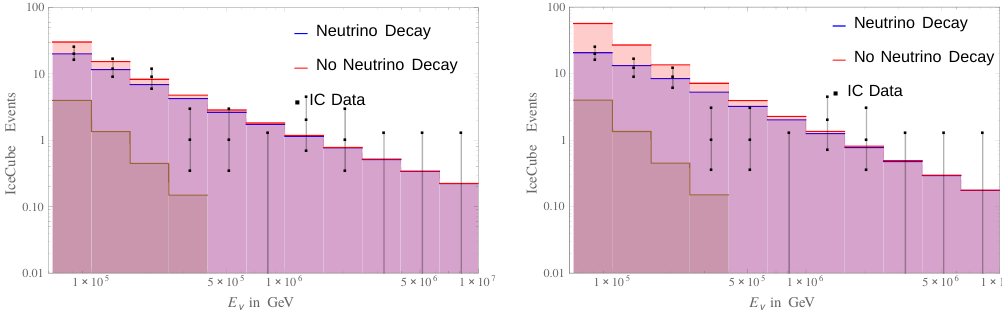
Figure 6 . IceCube event distribution with comparison of the cases of no neutrino decay for a. (cid:8) 0 = 2 (cid:2) 10 (cid:0) 18 (GeV cm 2 s sr) (cid:0) 1 , (cid:13) = 2 : 8 (left) b. (cid:8) 0 astro (right) with cases with a visible neutrino decay a. (cid:12) = 5 (cid:2) 10 4 GeV (left) and b. (cid:12) = 1 : 25 (cid:2) 10 5 GeV (right) respectively. Atmospheric neutrino background is shown as brown shaded